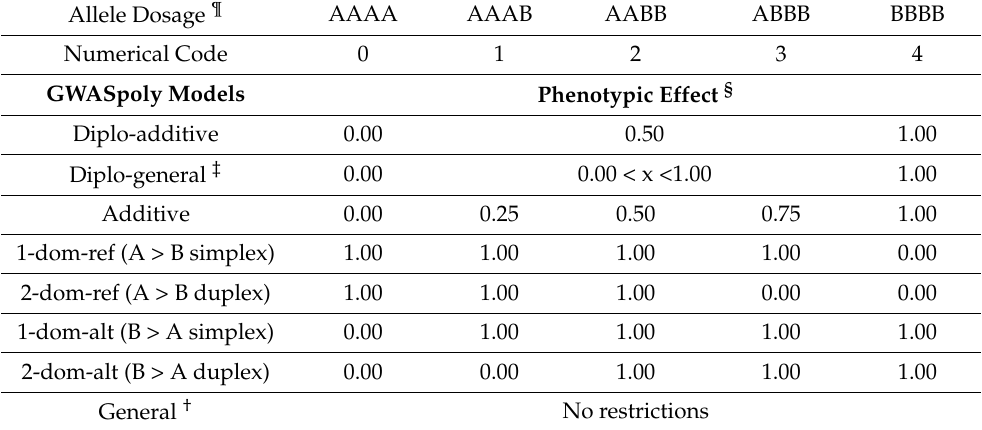
Table 3. Coding effect assumptions of GWASpoly models according to allele dosage in biallelic